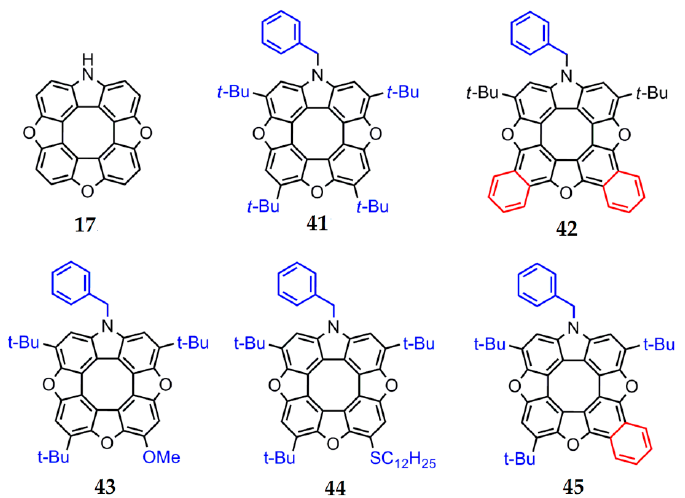
Figure 12. The structure of the parent ‘‘hypothetical’’ azatrioxa[8]circulene frame 17 (without the